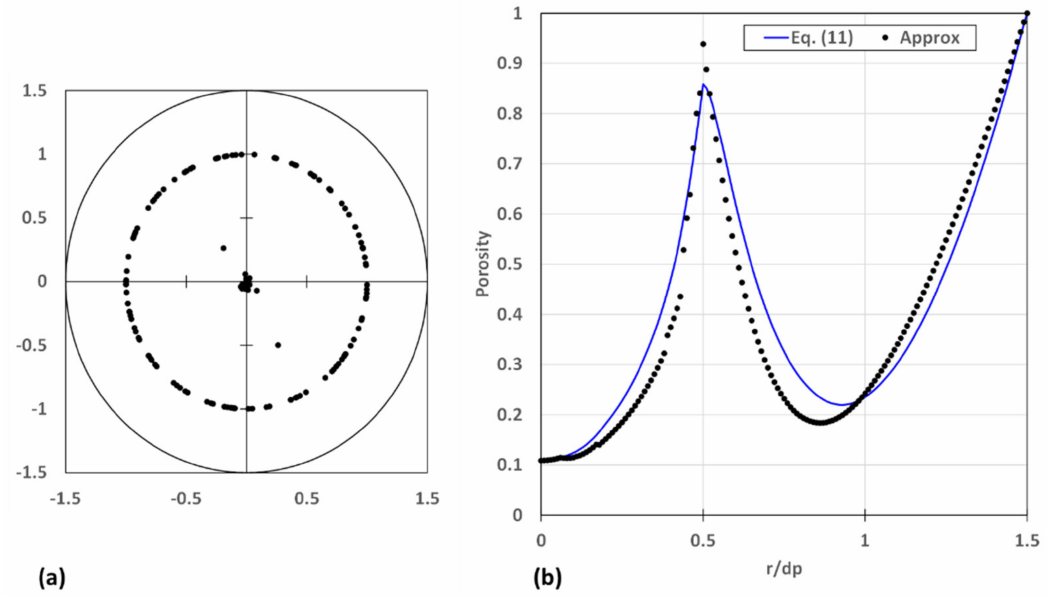
Figure 6. ( a ) Positions of centres of the spheres and ( b ) the radial variations in porosity based on Equation (11) and the approximate expression for D / d p =